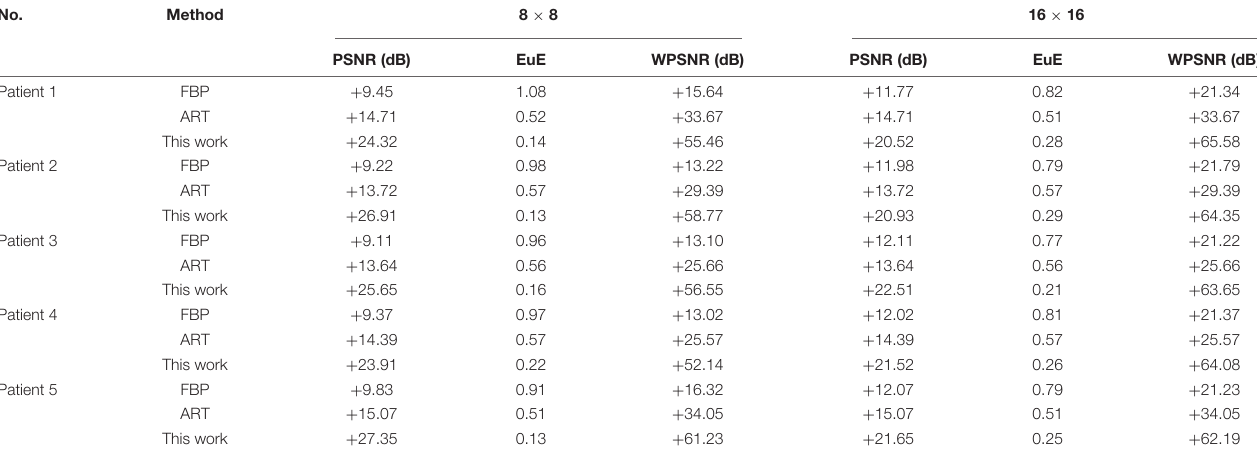
TABLE 7 | Comparison of proposed cost function-based reconstruction with other works for 8 × 8-, and 16 × 16-sized square images using lesser number of projections ( p = 18).